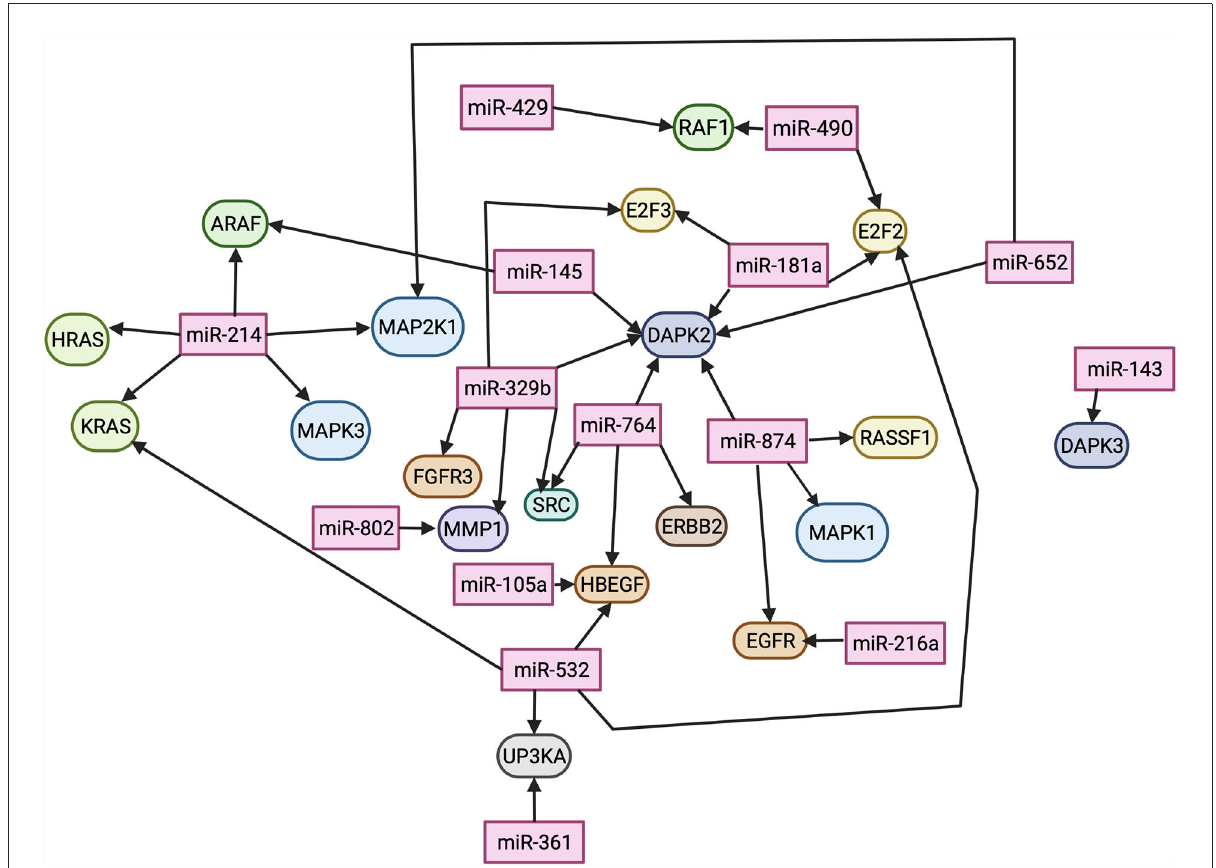
FIGURE6 Differentially expressed miRNAs and their predicted protein targets, evaluated through miRWalk. Lines connecting miRNAs to proteins indicate an interaction. Image created using